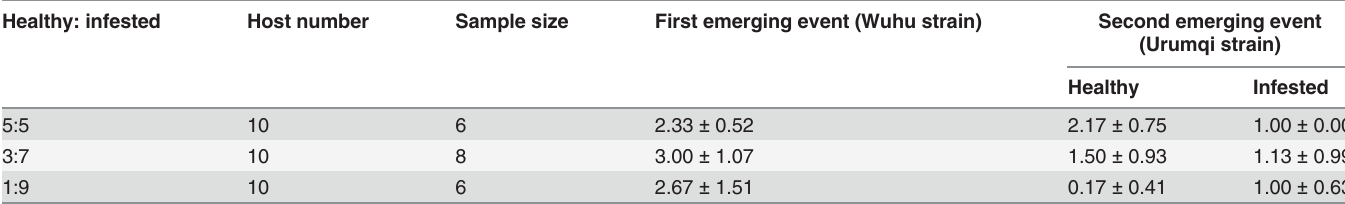
provided with a proportion of 50%, 30% and 10% in the oviposition patch (Table 5). The re- sults suggest that the conspecific hyperparasitism behavior might not be a phenomenon only when healthy hosts are extreme lacking. But we had not proved the behavior in the field. And whether the conspecific hyperparasitism behavior was popular in natural environments needs further research.